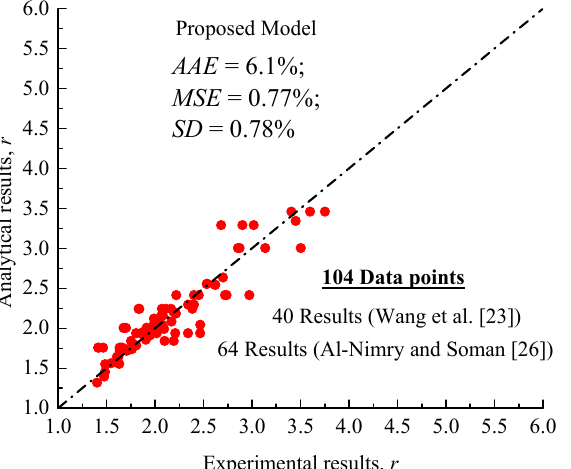
Figure 9. Correlation between experimental and analytical results of the shape factor r estimated using Equation (18).